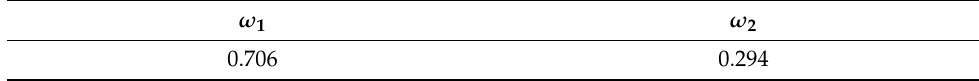
Table 3. First-level index weight